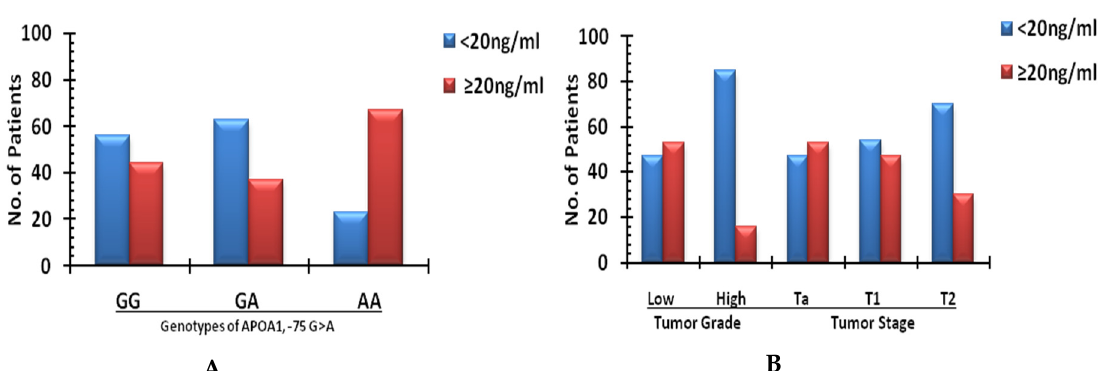
Figure 1. ( A,B ) : Different concentrations of APOA1 urinary protein with ( A ) genotypes of APOA1 − 75 G/A and ( B ) with different grades and stages of the patients with bladder cancer.